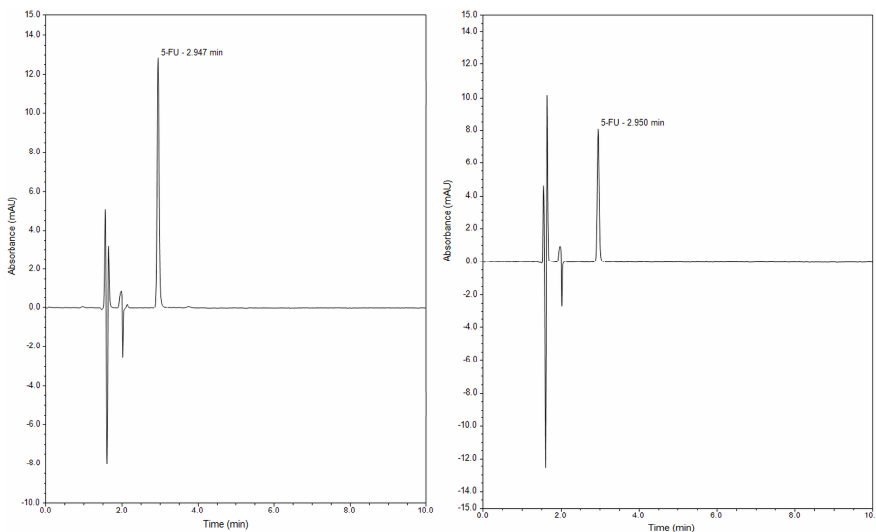
Figure 11. Representative chromatogram of 5-FU released during 4 h from SBA-15 into medium with pH = 2 (left) and medium with pH = 7 (right).